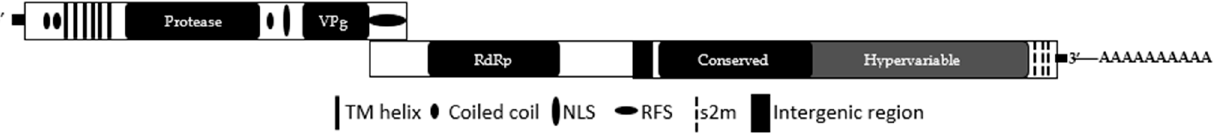
Figure 1. Genomic organization of CAstV. TM helix, Transmembrane helix; NLS, Nuclear localization signal; RFS, Ribosomal frameshift; s2m, Stem-loop II-like motif; VPg, viral protein genome linked; RdRp, RNA dependent RNA-polymerase and AAAAA, polyadenylated tail.